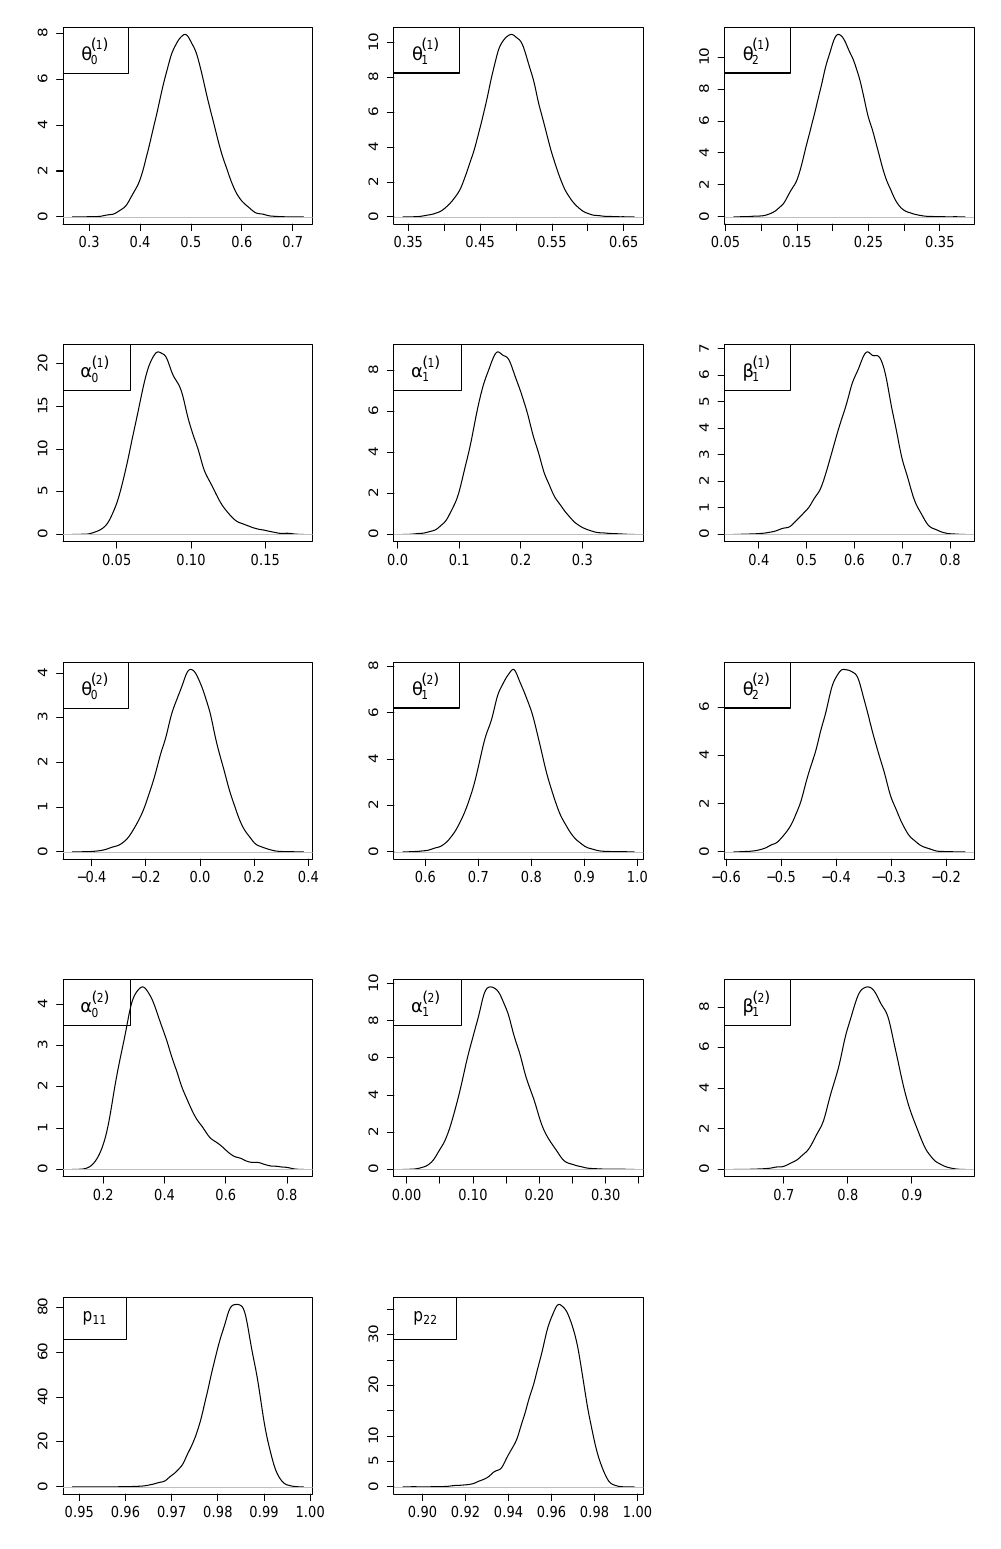
Figure 5. Estimated posterior densities of the simulated